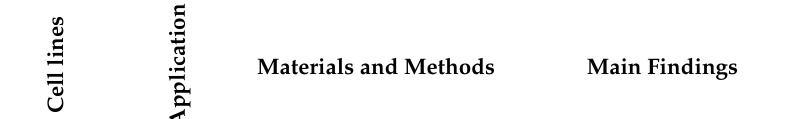
Table 2. Three-dimensional models generated with glioblastoma cell